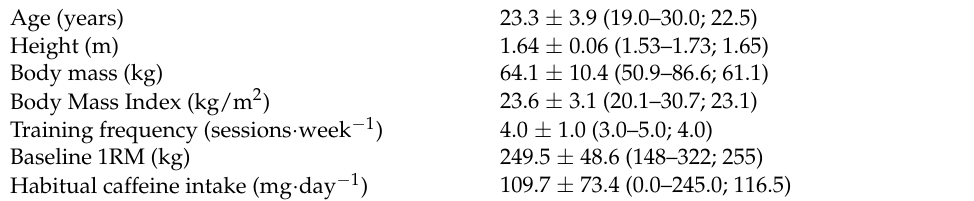
Table 1. Participant